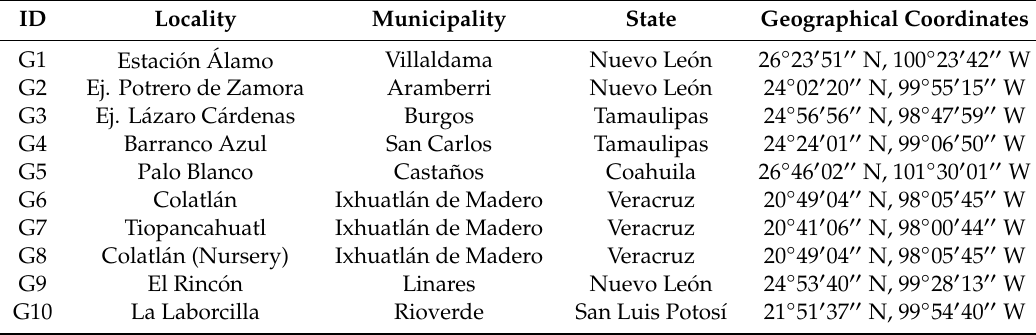
Table 1. Identification and origin of 10 piquin pepper